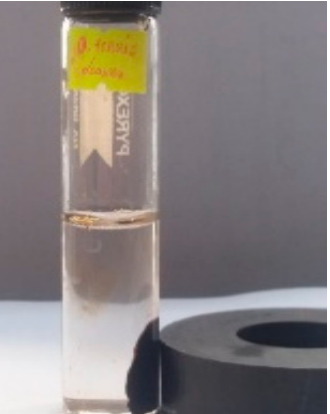
Figure 1. Movement of Fe 3 O 4 NPs at the side of the external magnetic field.